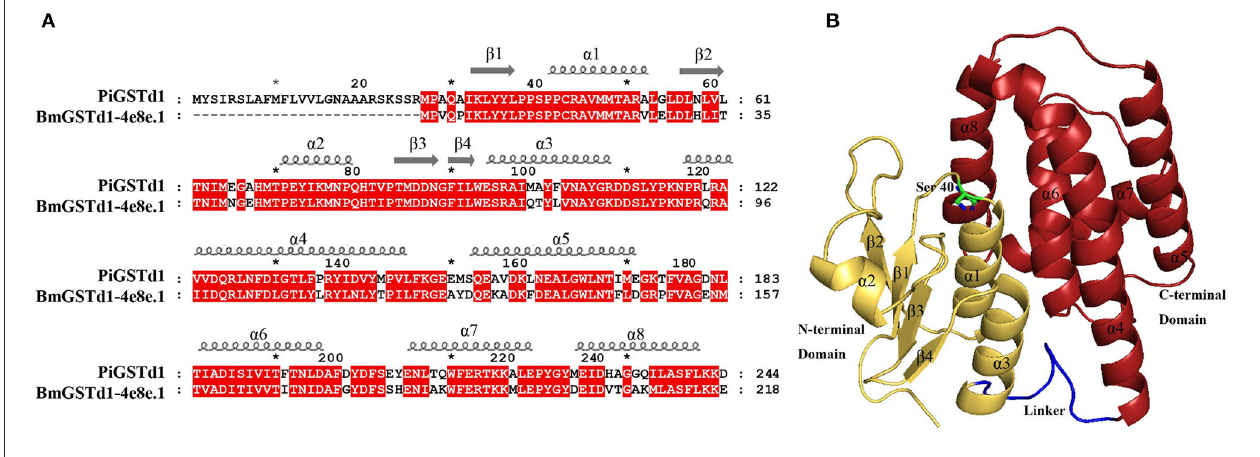
FIGURE 4 | Structural characterization of PiGSTd1. (A) Sequence alignment of PiGSTd1 and BmGSTd1 (PDB ID: 4e8e.1). (B) Homology model of PiGSTd1. Yellow, red, and blue represent N-terminal domain, C-terminal domain, and linker, respectively. Ser40 in green is proposed to be catalytically essential.